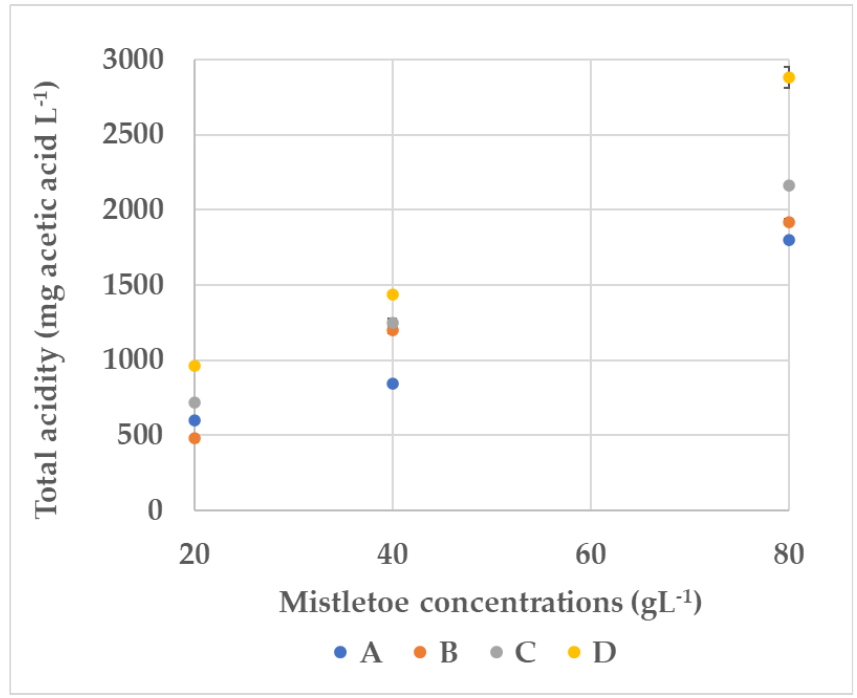
Figure 3. Total acidity of mistletoe macerates prepared by maceration of 20 g/L, 40 g/L, and 80 g/L mistletoe in ethanol – water solution (A: 25%, B: 40%, C: 55%, and D: 70% v/v ethanol) at room tem- mistletoe in ethanol–water solution (A: 25%, B: 40%, C: 55%, and D: 70% v / v ethanol) at room perature and in darkness, after 28 days of maceration . temperature and in darkness, after 28 days of